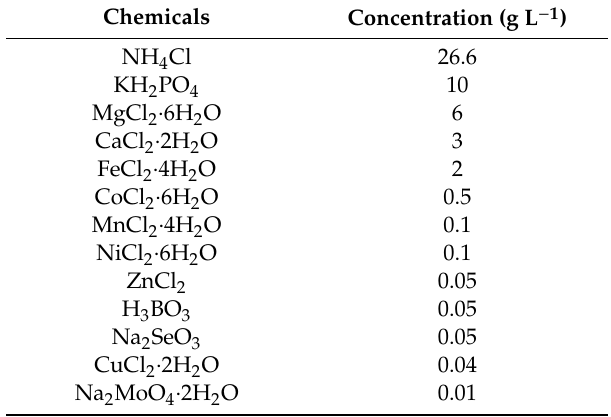
Table 4. Composition of the nutritive solution used in the second